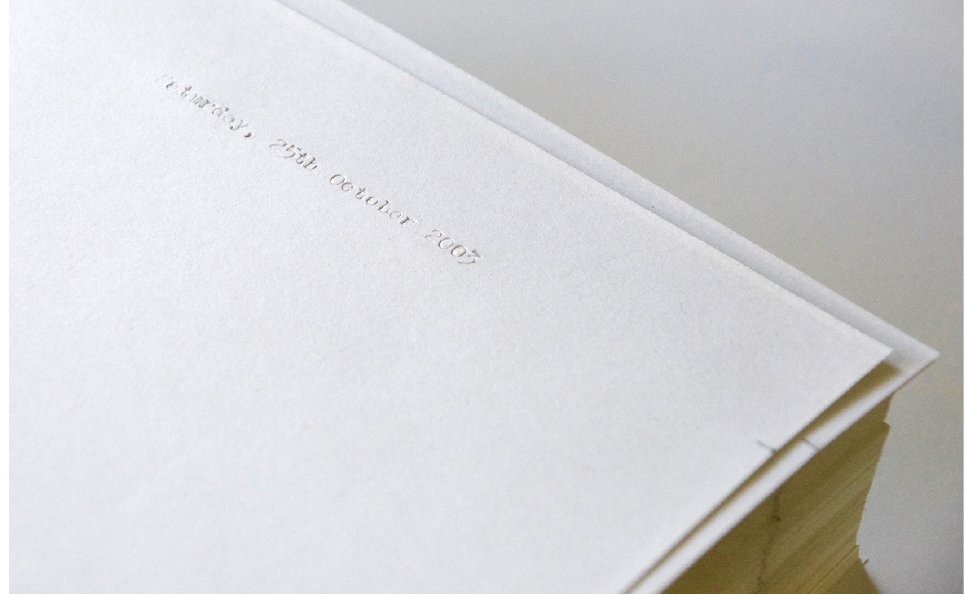
Figure 2. The days we’ve been together , 2018. Te Uru Wait ā kere Contemporary Gallery, Titirangi, T ā maki Makaurau Installation detail of Blind Carbon Copy: An Open Love Letter curated by Ioana Gordon-Smith. Typewriter marks on paper, dimensions variable. Collection of the artist. Photo: Sam Hartnett.